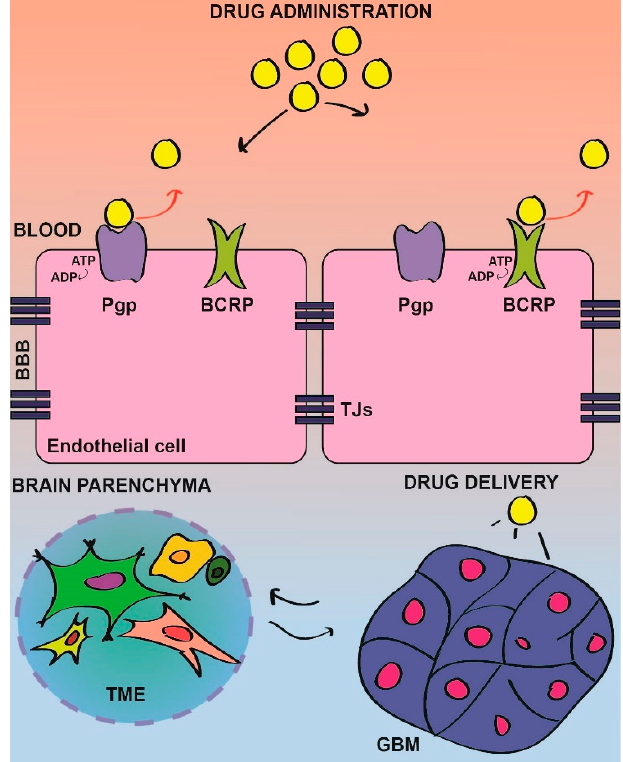
Figure 1. Schematic illustration of the drug delivery through the blood–brain barrier (BBB) in GBM.